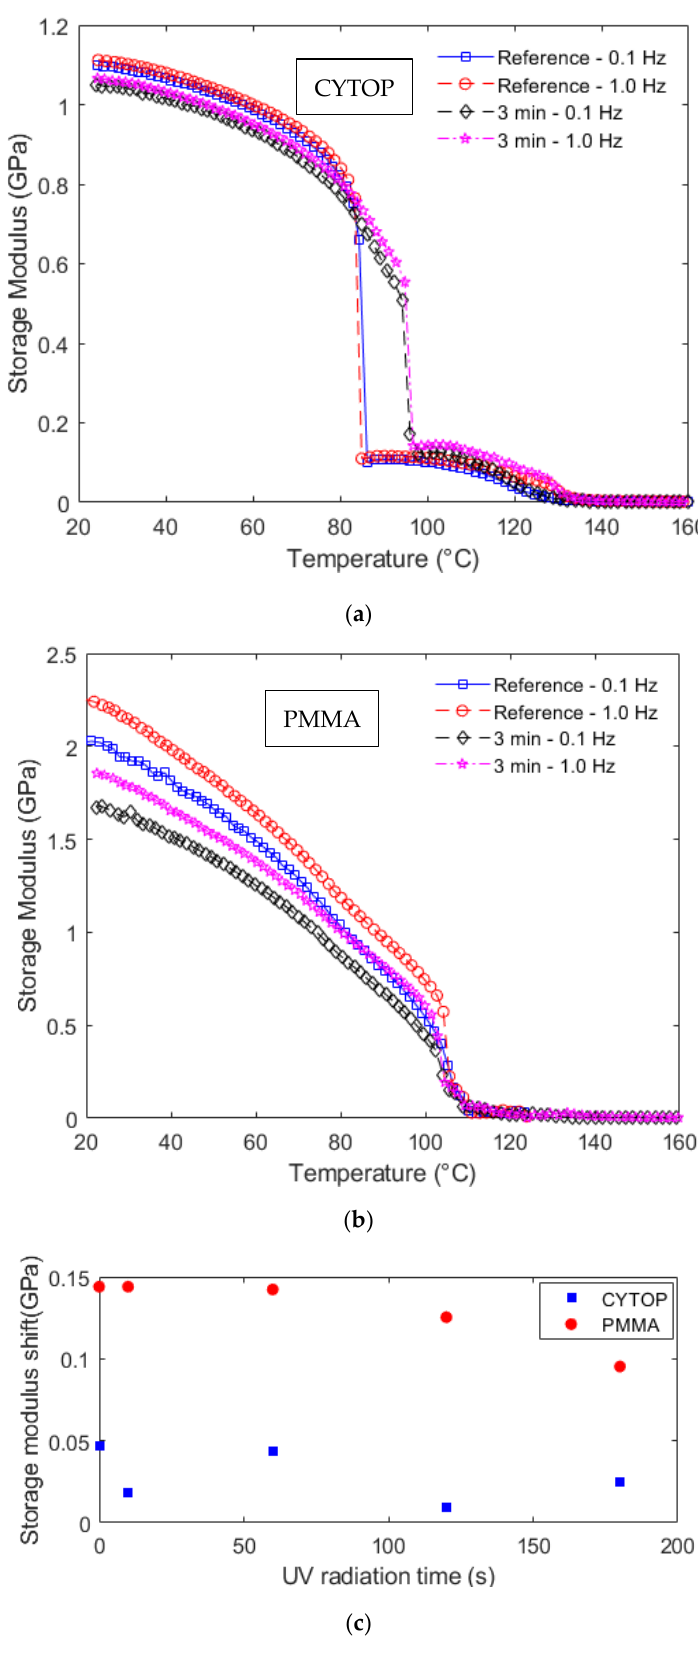
Figure 6. Storage modulus as a function of the temperature at different frequencies for ( a ) CYTOP and ( b ) PMMA fiber. ( c ) Storage modulus shift at 80 ◦ C for all samples at different UV radiation